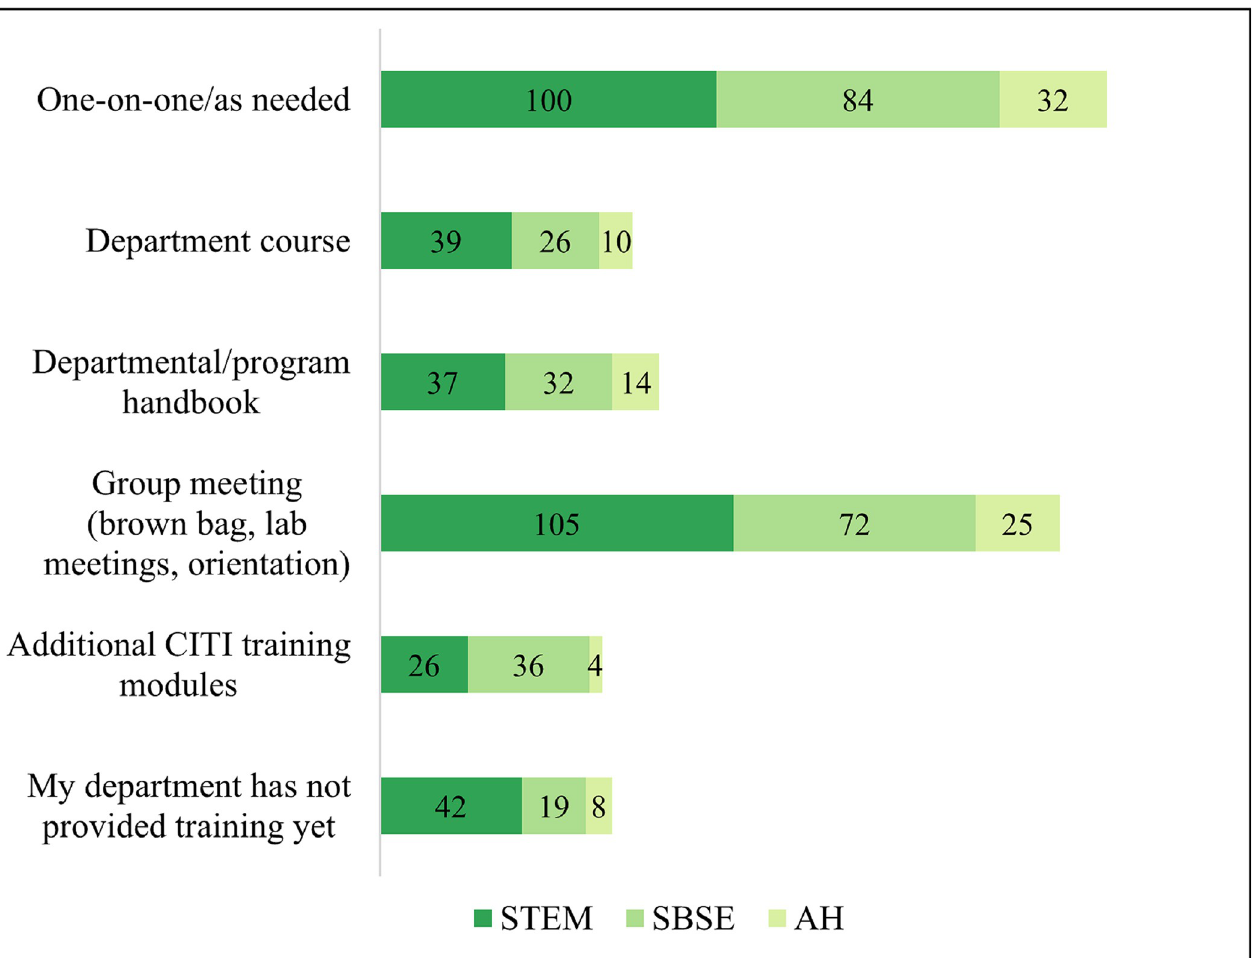
Fig 5. Stage III: Departmental RCR training activities by